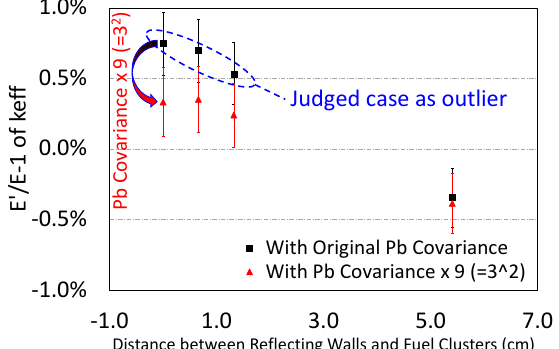
Fig. 9 . E'/E-1 of keff of LCT-010 cases 1 - 4